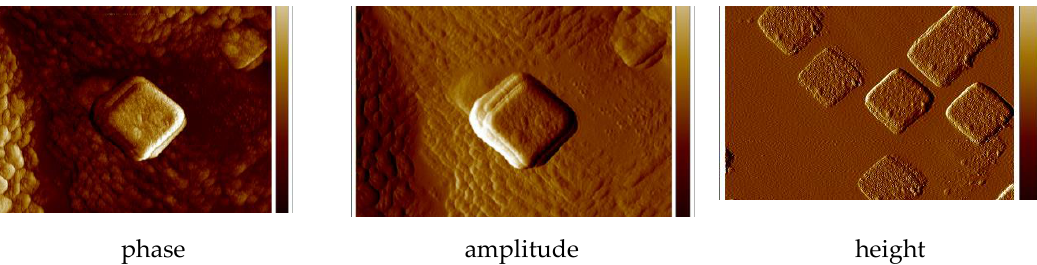
Figure 13. AFM of {[Cu 2 (L1)Cl 2 ] 2 [CuCl 4 ]}·2MeCN·2H 2 O ( 1 ), PMMA/Si; PMMA ×1, PMMA